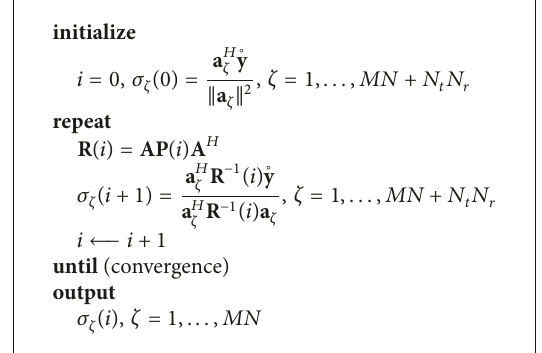
Algorithm 1: 2 D IAA algorithm for the deramping based range- azimuth